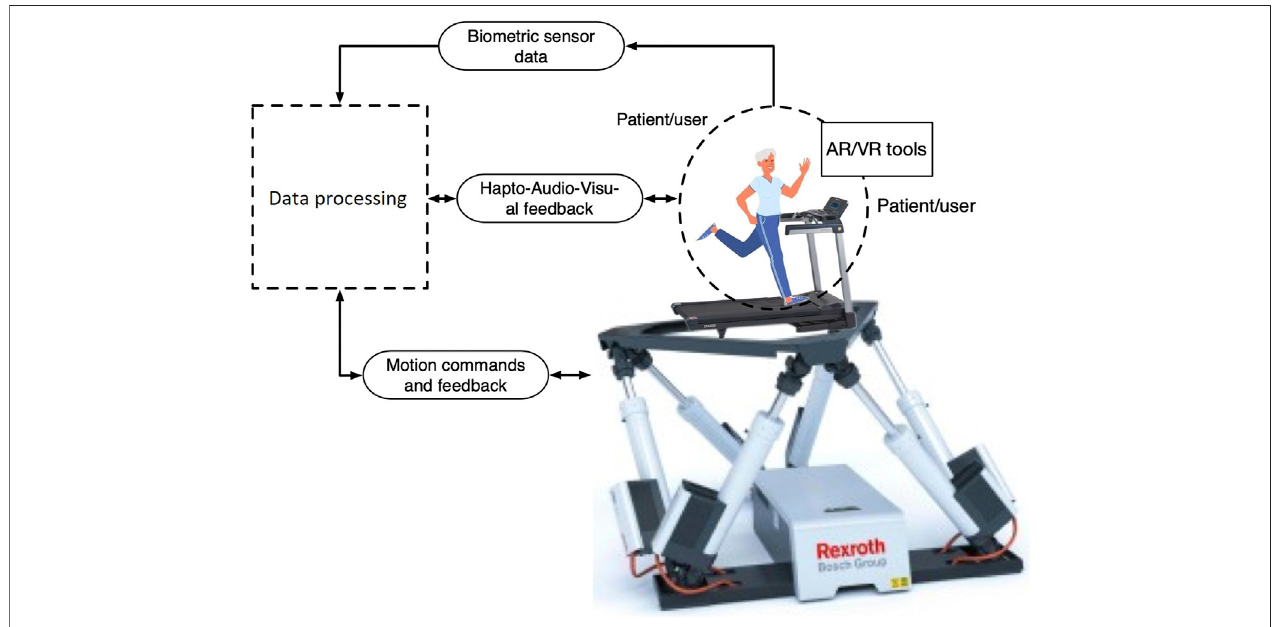
TABLE 4 | Therapeutic aim and game design choices. Therapeutic aim Game design choices Postural control, balance, weight